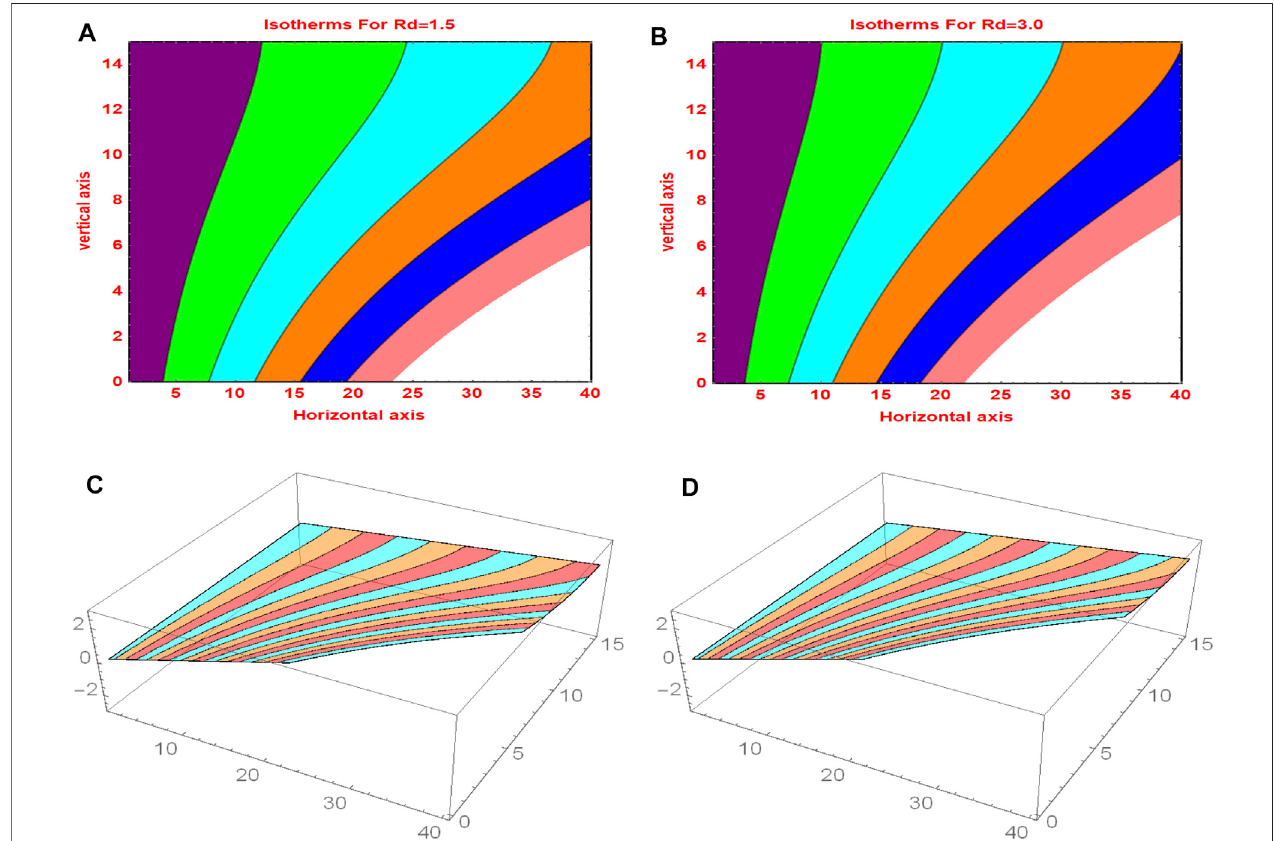
FIGURE 17 | Isotherms via (A) Rd (cid:2) 1 . 5, (B) Rd (cid:2) 3 . 0, (C) 3D for Rd (cid:2) 1 . 5, and (D) 3D for Rd (cid:2) 3 . 0.